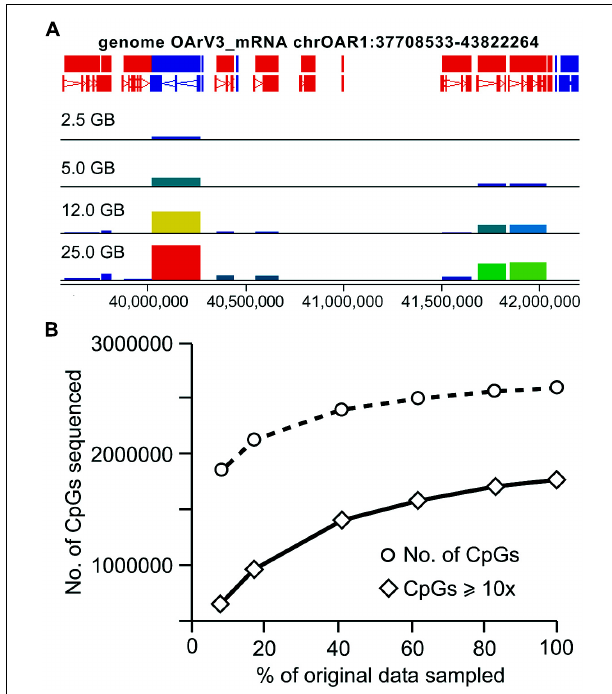
FIGURE 5 | CpG coverage generated from RRBS when smaller amounts of data are available for analysis. RRBS data were randomly sampled from the original fastq file to create smaller data sets, (A) Seqmonk screen shot illustrating CpG site coverage across selected genes on chromosome 1, bar height represents a count of CpG coverage, illustrating inclusions of increasing number of genes analyzed as the number of sequences included increases; (B) The number of CpGs covered in these sequentially smaller datasets was identified, in addition to the number of CpGs with at least 10x coverage.